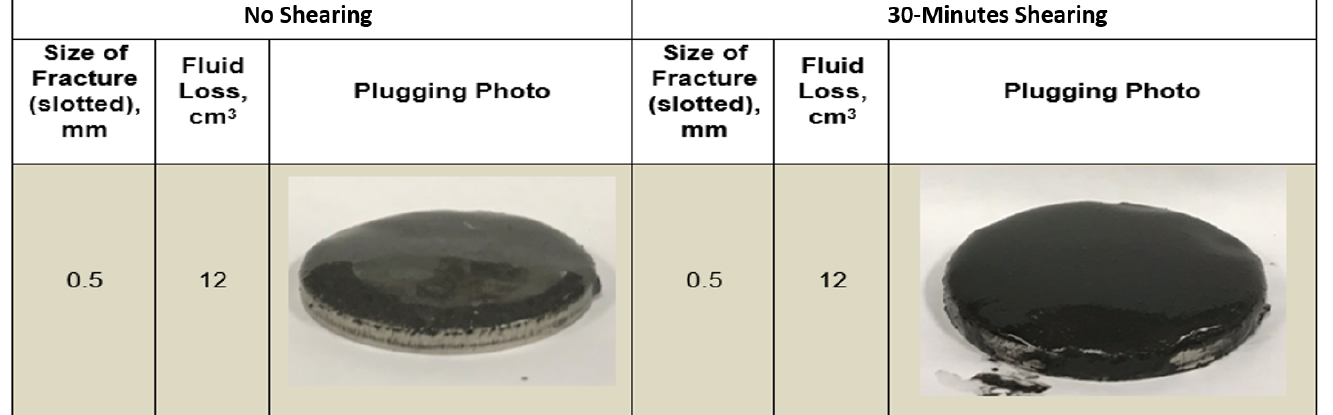
Figure 6. Graphite maximum plugged fracture diameter before and after shearing force.